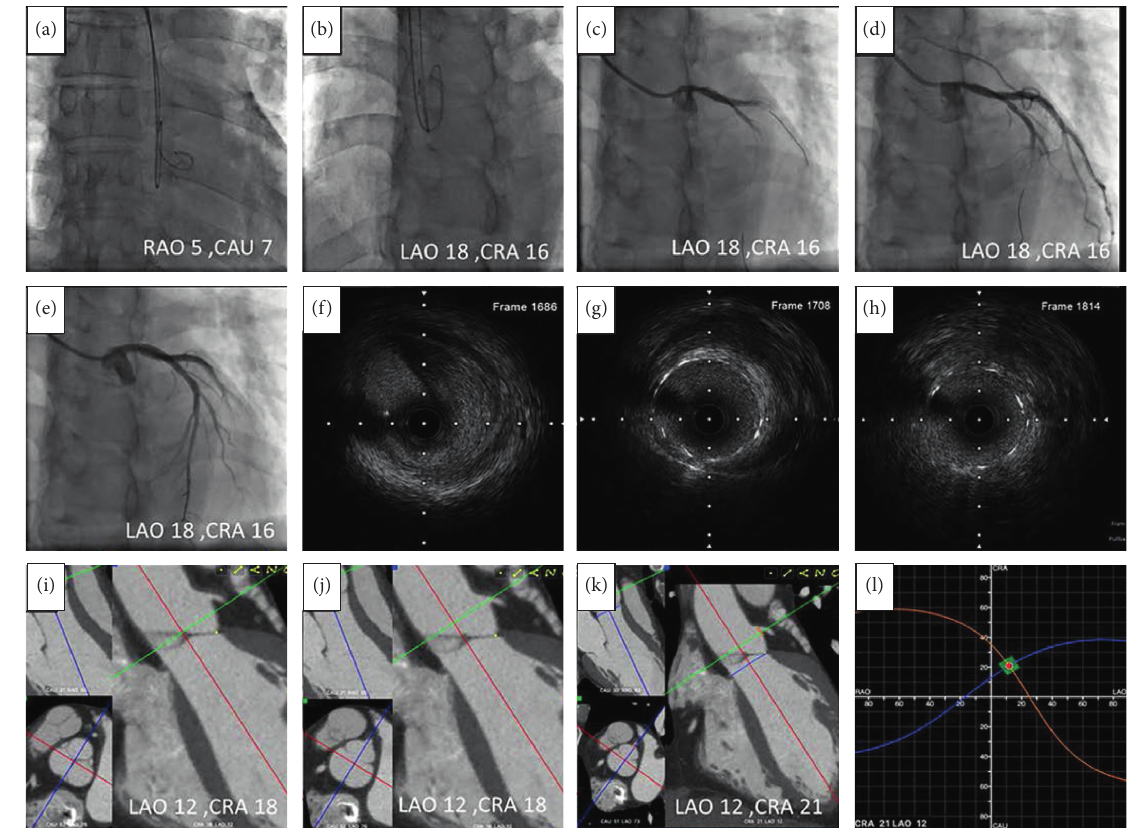
Figure 7: (a) Two 0.035-inch wires were advanced to the NCC and RCC using the anterior-posterior view; (b) the lowest points in the curve at the distal part of these two wires were superimposed at LAO18/CRA16; (c) LMCA angiography was performed at the angulation; (d) the stent was located at the angulation; (e) the image of LMCA after stent deployed; (f) LMCA ostial lesion was showed by intravascular ultrasound (OptiCrossTM HD; Boston Scientific) that was withdrawn at a pullback speed of one millimeter equal to 60 frames before stenting; (g, h) in the poststenting pullback, the LMCA ostium was at frame 1708 and the stent ostium was at frame 1814. So the stent protruded to the aorta for 1.77mm ((1814–1708)/60); (i) the NCC and RCC overlapped at LAO12/CRA18 by FluoroCT; (j) the LMCA ostium faced to the NCC-RCC commissure in this patient (bottom left corner); (k) blue line was aortic valve plane and orange line was LMCA plane; (l) the two S-curves consisting of an unlimited number of pairs of C-arm angulations which were tangential to the aortic annulus and LMCA ostium crossed at LAO12/CRA21. CAU � caudal; CRA � cranial; LAO � left anterior oblique; RAO � right anterior